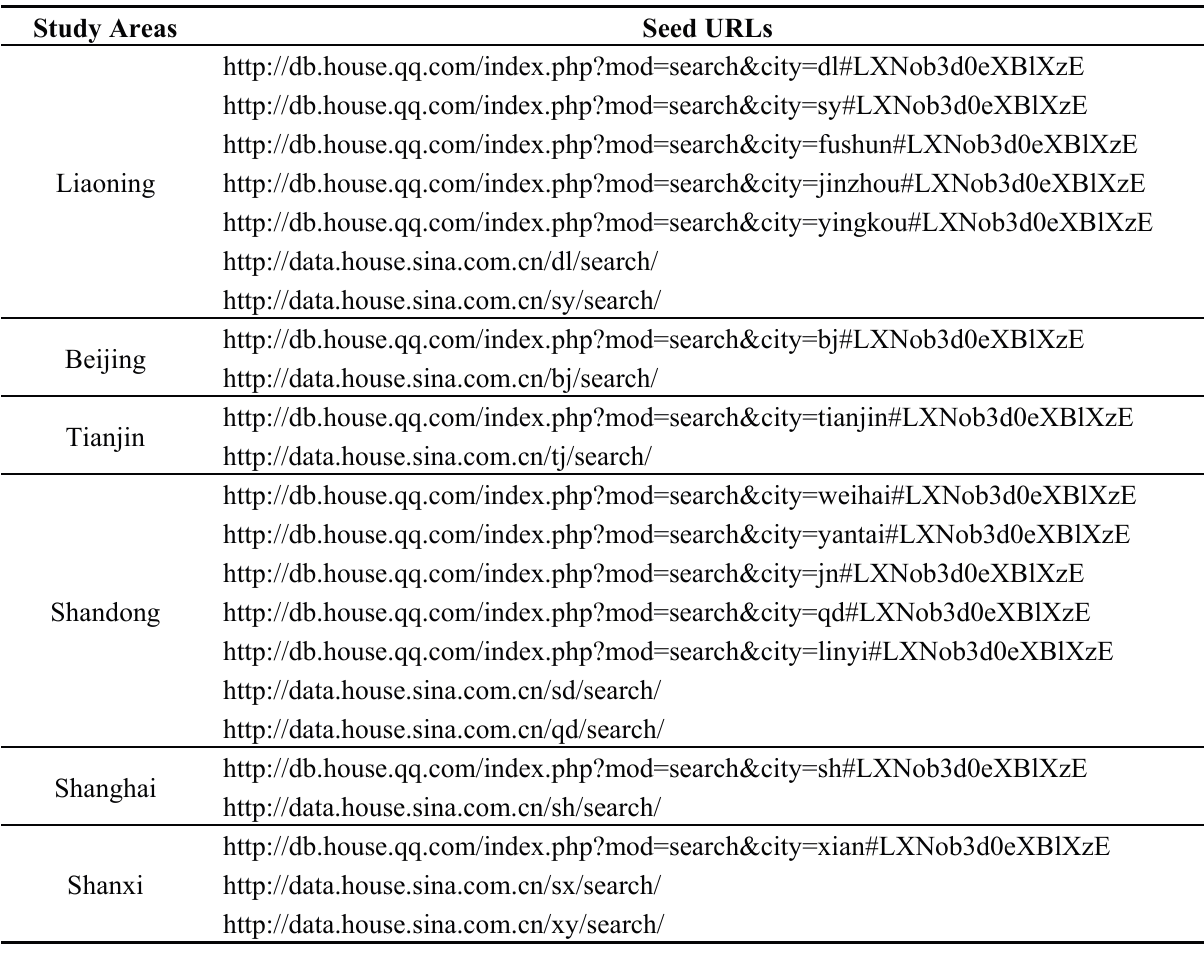
Table 3. Seed URLs from two different